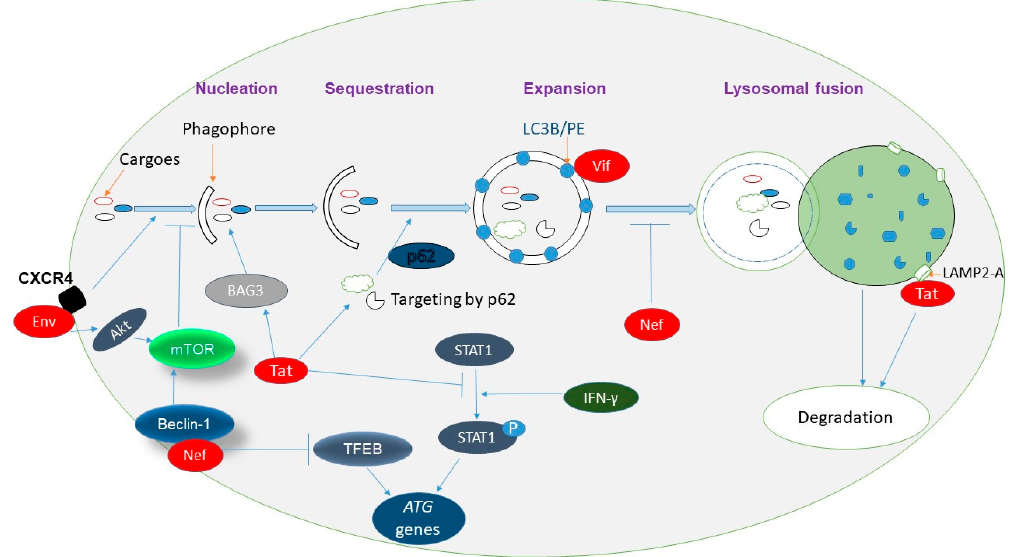
Figure 1. Interaction of different human immunodeficiency virus type 1 (HIV-1) proteins with the autophagy pathway. HIV-1 transcription transactivator (Tat) stimulates autophagy by increasing Bcl-2 associated athanogene 3 (BAG3) levels in human glial cells. On the other hand, Tat interferes with interferon (IFN)- γ -induced autophagy through the suppression of signal transducer and activation of transcription 1 (STAT1) phosphorylation, resulting in the reduced expression of autophagy genes including microtubule-associated protein 1 light chain 3 (LC3B). Interaction of Tat with sequestosome 1 (SQSTM1) leads to the targeting of Tat to lysosomal-mediated degradation via selective autophagy. Tat also interacts with lysosomal associated membrane protein 2A (LAMP2A), suggesting its role in lysosomal fusion in neurons. HIV-1 negative expression factor (Nef) is an anti-autophagic maturation factor which interacts with Beclin-1 resulting in activation of mammalian target of rapamycin (mTOR) and phosphorylation and cytosolic sequestration of transcription factor EB (TFEB), decreasing the biosynthesis of ATG proteins. HIV-1 envelope (Env) induces autophagy after binding to C-X-C chemokine receptor type 4 (CXCR4) on bystander CD4 + T cells. HIV viral infectivity factor (Vif) interacts with LC3B on the surface of autophagosomes and can block autophagic flux.